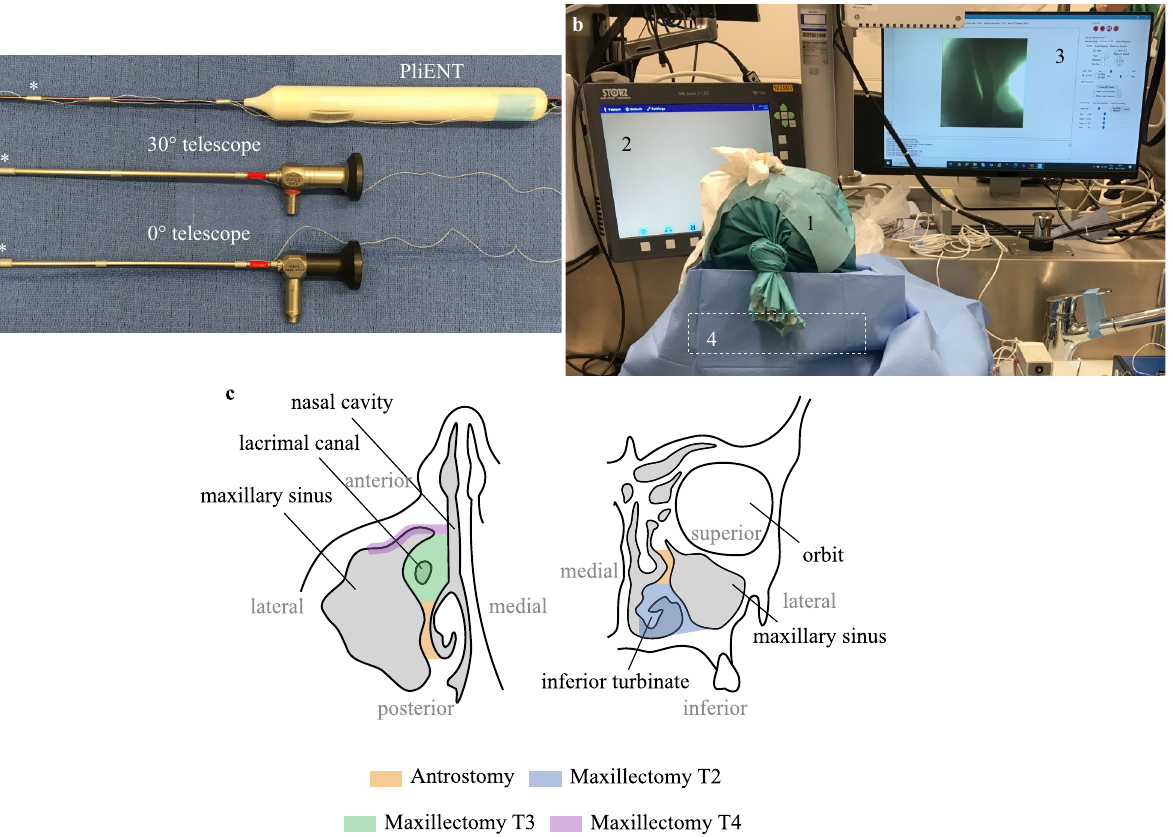
Figure 3. Experimental set-up and protocol for maxillary sinus inspection. ( a ) instruments used for the inspection of the cadaver’s maxillary sinus. Single-handed, flexible, steerable endoscope PliENT (top); Hopkins II forward-oblique rigid endoscope 30° (Karl Storz, Tuttlingen, Germany) (middle); Hopkins II straight forward rigid endoscope 0° (Karl Storz, Tuttlingen, Germany) (bottom). The locations of the 6 DOF electromagnetic sensors are indicated with the star symbol (*); ( b ) cadaver experiments set up consisting out of: 1. cadaver’s head; 2. Tele pack X LED for endoscopic view of the rigid endoscopes; 3. NanEye viewer for endoscopic view of the PliENT endoscope; 4. Aurora electromagnetic tracking system box; ( c ) maxillary sinus and nasal cavity anatomy in the transverse (left) and coronal (right) plane. The different enlargement procedures are colored as follows: orange = antrostomy; blue = maxillectomy type 2; green = maxillectomy type 3; purple = maxillectomy type